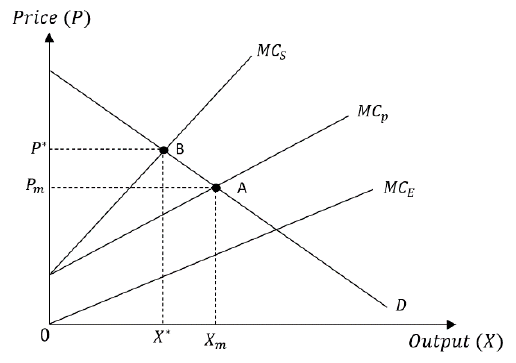
Figure 1. Depiction of a negative externality.